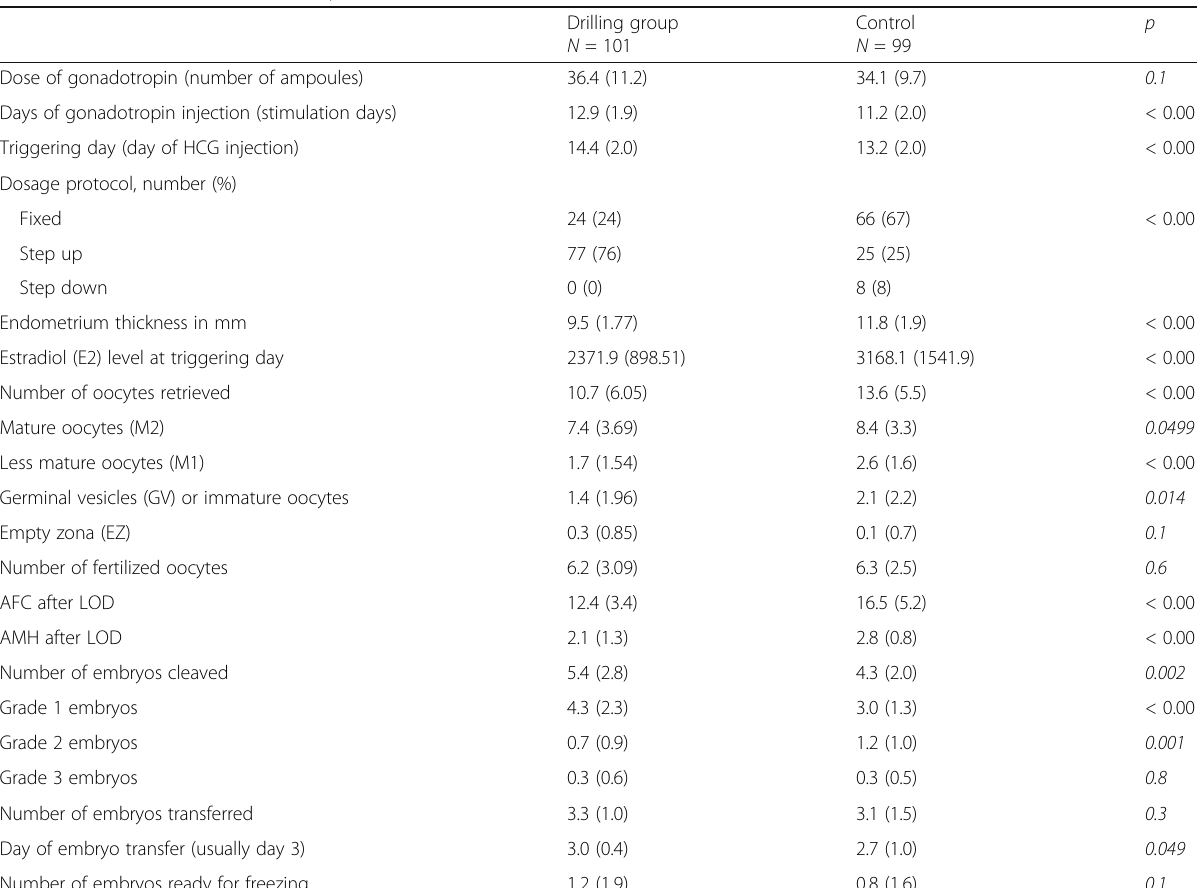
Table 2 Ovarian induction and ICSI parameters